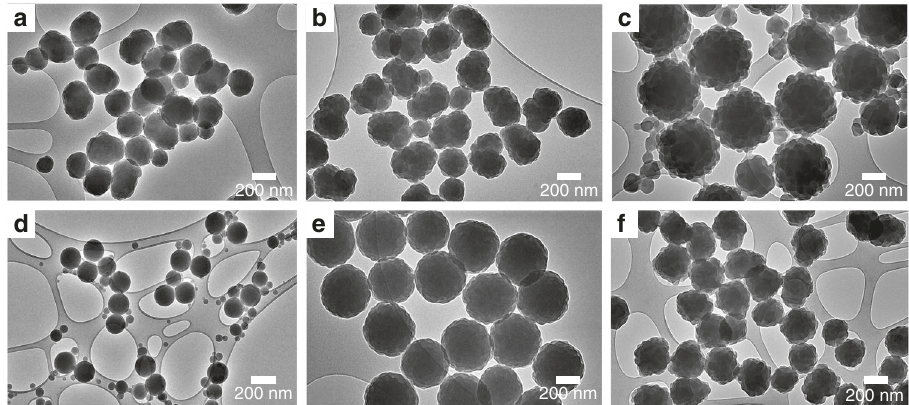
Fig. 2 Effect of solvent condition and cross-linker on raspberry-colloid synthesis. TEM images of colloids synthesised in a pure water, b a 90/10 v/v, and c in a 70/30 v/v water/ethanol mixture, respectively, using in all three cases the same composition of AM, St and the cross-linker DVB used for ideal raspberries. The average hydrodynamic diameter of the particles determined by dynamic light scattering (DLS) were 300, 245 and 330 nm, respectively. d TEM image of particles synthesised using the ideal 80/20 v/v water/ethanol mixture but omitting DVB. e , f Colloids synthesised in the same 80/20 v/v mixture but using only St and DVB ( e ) and St, DVB plus half the required amount of AM ( f ), respectively particles with a ZP of + 42 mV (Fig. 5b, Supplementary Fig. 9) DLVO theory for even higher salt concentrations becomes were computed and are presented as a function of particle questionable. separation for 0.5 mM added NaCl salt, which corresponds to our In Fig. 5d, e, we demonstrate the stability against salting in a experimental starting con fi guration. The DLVO calculations were salting series of our raspberry and the similarly sized and charged then repeated with the same settings but for increasing salt smooth PS particles. We start with an added salt concentration of concentrations up to 500 mM added NaCl. Application of the 0.5 mM and go up to 5 M. While the raspberry suspensions